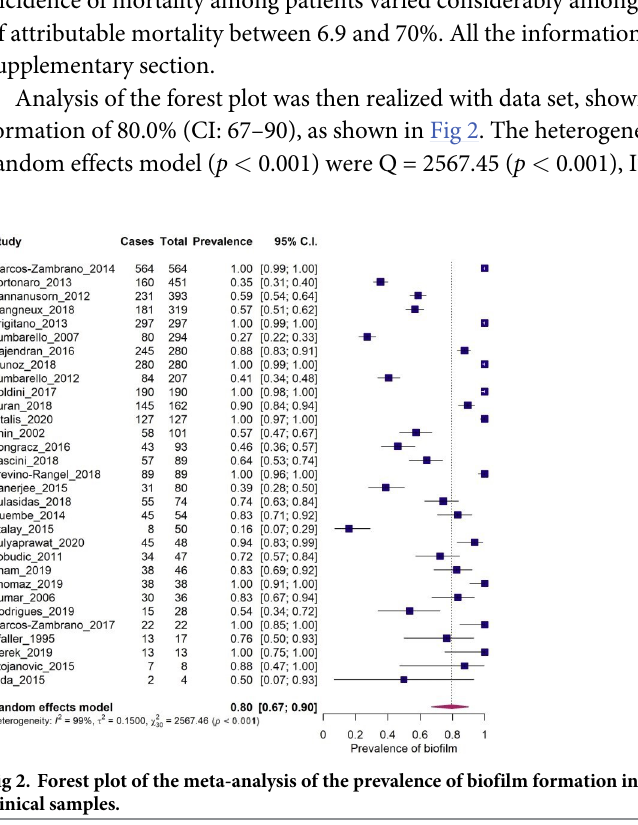
Fig 2. Forest plot of the meta-analysis of the prevalence of biofilm formation in Candida spp. isolated from blood clinical